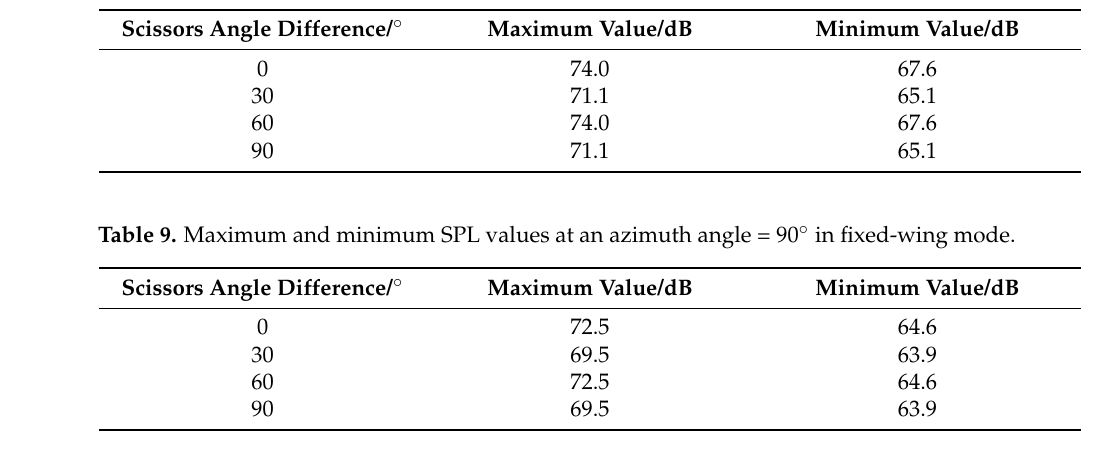
Table 10. Maximum and minimum SPL values at an azimuth angle = 180 ◦ in fixed-wing mode. Scissors Angle Difference/ Scissors Angle